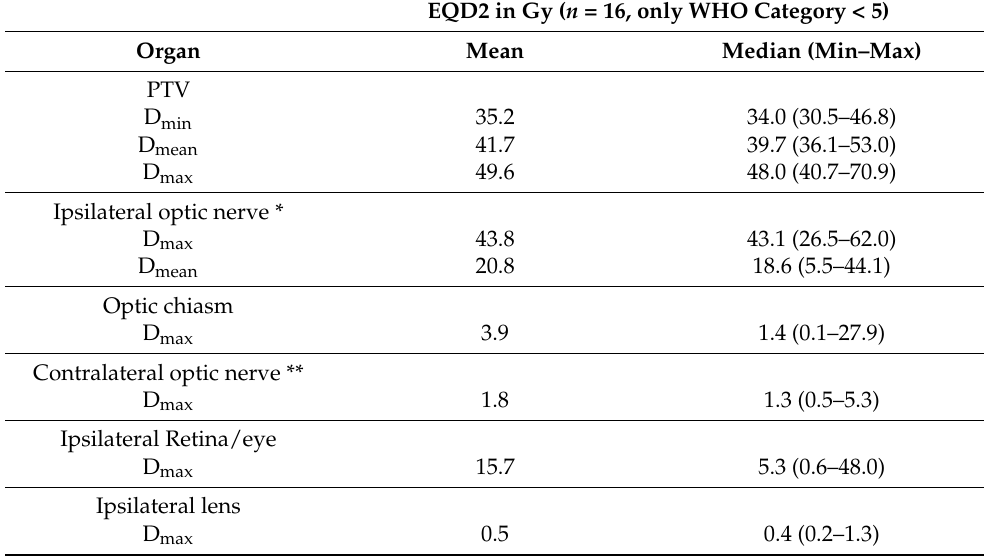
Table 3. Equivalent doses for 2 Gy fractions of the target volume and relevant organs at risk ( n = 16, only WHO category < 5). EQD2 in Gy ( n = 16, only WHO Category < 5) Organ Mean Median (Min–Max)